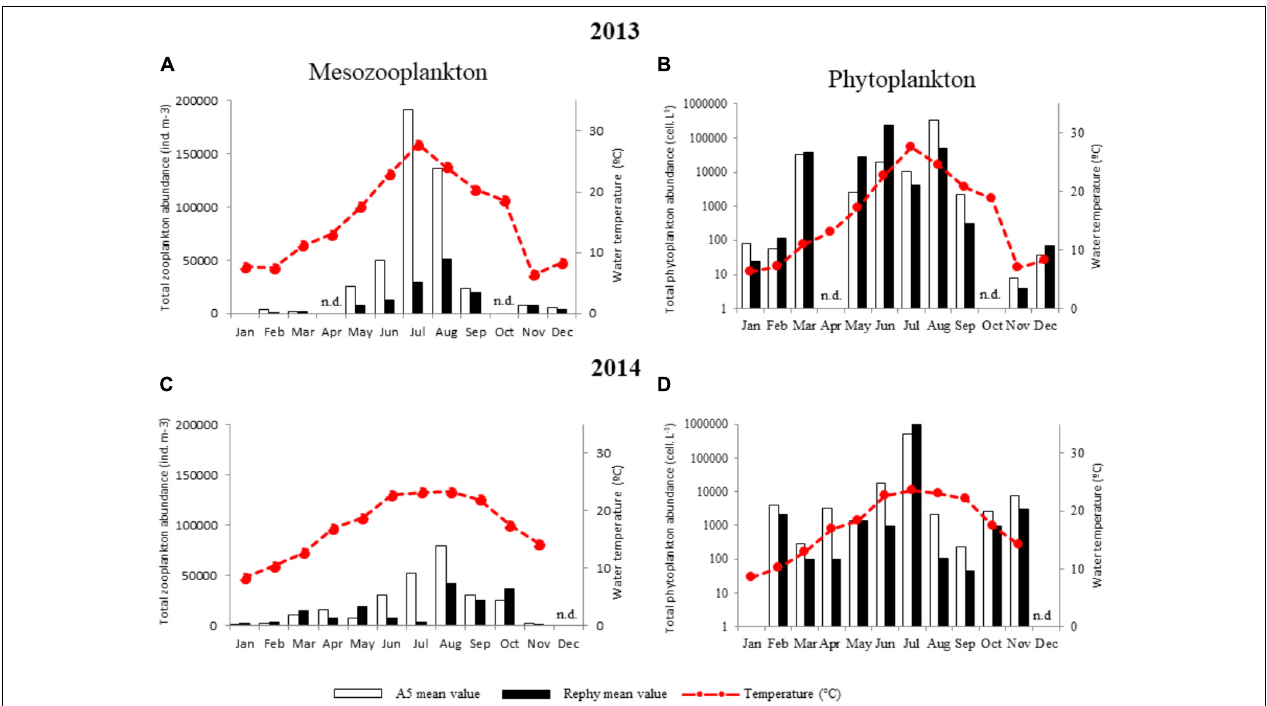
FIGURE 4 | Monthly abundance of total mesozooplankton and phytoplankton. (A,B) 2013 and (C,D) 2014 monthly values of plankton abundance outside (A5, white bars ) and inside oyster farms (Rephy, black bars ). Total mesozooplankton counts (individuals m - 3 ) are shown in (A,C) . Total phytoplankton counts (cells L - 1 ) are shown in (B,D) . n.d., not